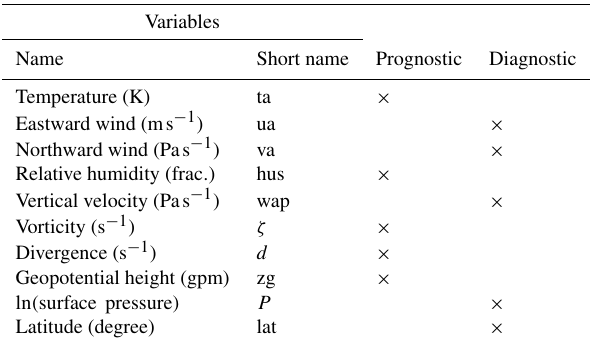
Table 2. Variables used in the